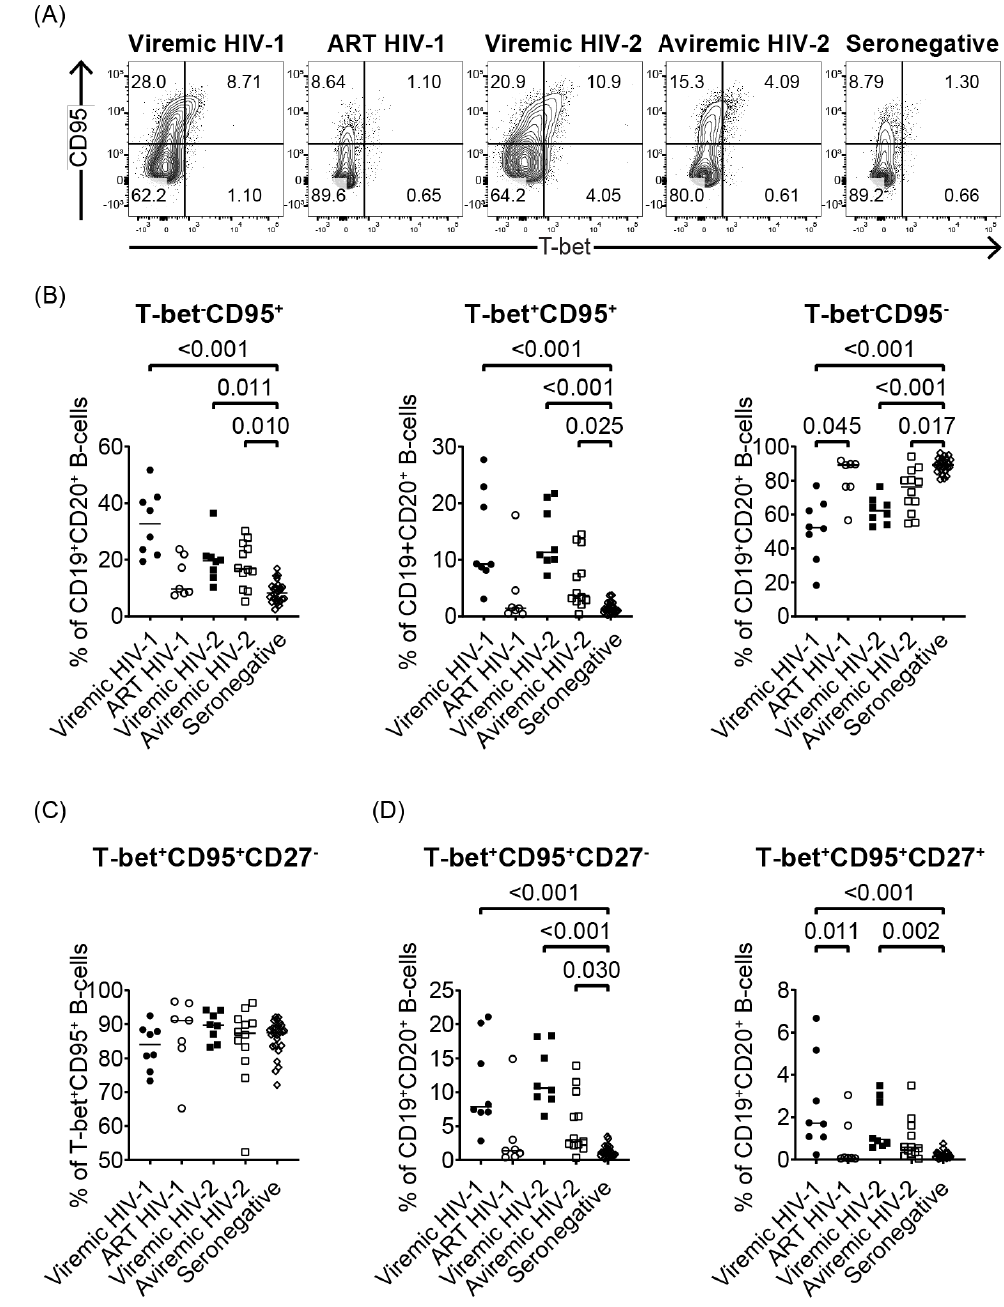
Figure 1. Both HIV-1 and HIV-2 infection induces T-bet expression in CD19 + CD20 + B-cells. ( A ) Representative flow cytometry plots depicting CD95 and T-bet expression on CD19 + CD20 + B-cells in treatment-naïve or sub-optimally ART-treated HIV-1 (viremic HIV-1, n=8), successfully ART-treated HIV-1 (ART HIV-1, n = 7), viremic HIV-2 (viremic HIV-2, n = 8), treatment-naïve aviremic HIV-2 (aviremic HIV-2, n = 12)-infected individuals and HIV seronegative (seronegative, n = 25) individuals. ( B ) Scatter plots illustrating the percentage of T-bet + CD95 + , T-bet + CD95 + and T-bet + CD95 + among B-cells in the different study groups. ( C ) Scatter plots illustrating the percentage of T-bet + CD95 + CD27 - among T-bet + CD95 + B-cells (CD19 + CD20 + ). ( D ) Scatter plots illustrating percentage of T-bet + CD95 + CD27 - and T-bet + CD95 + CD27 + cells among CD19 + CD20 + B-cells. Nonparametric Kruskal–Wallis test followed by Dunn’s post hoc was performed to compare groups. Medians are depicted in scatter